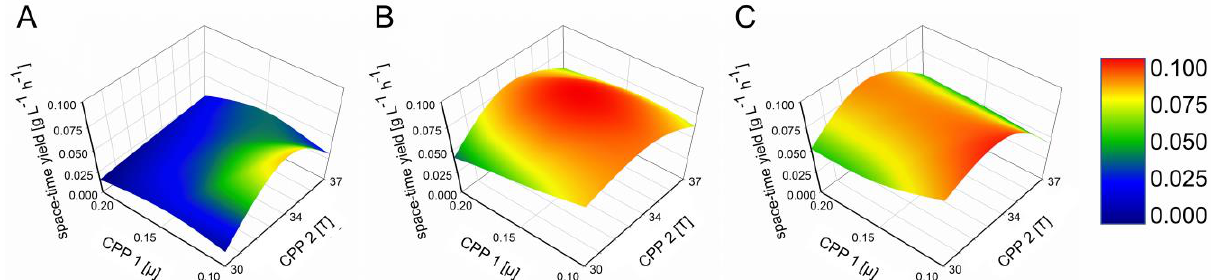
Figure 2. Response surfaces of the analytical space-time yield maxima in the design space. The maximum value of each CPP combination is displayed as a function of the specific growth rate and the cultivation temperature for each induction level: I = 0.2 ( A ), I = 0.5 ( B ), and I = 0.9 ( C ). The color indicates the values of the space-time yield from dark blue (lowest value) to red (highest value).